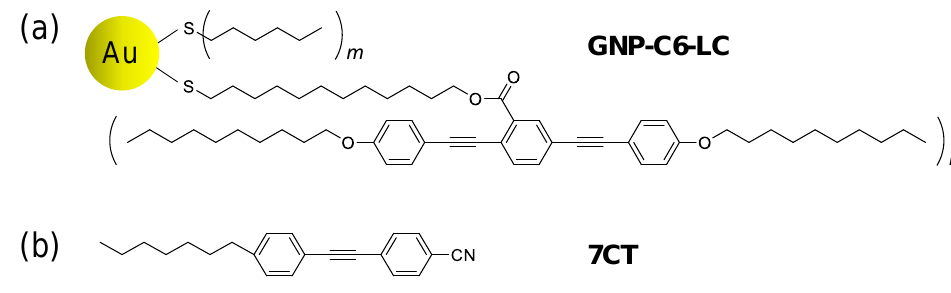
Figure 1. Molecular structures of ( a ) the liquid crystalline gold nanoparticles (GNP-C6-LC) and ( b ) the host nematic LC (7CT). The mesogenic groups in GNP-C6-LC were connected by “side- on”